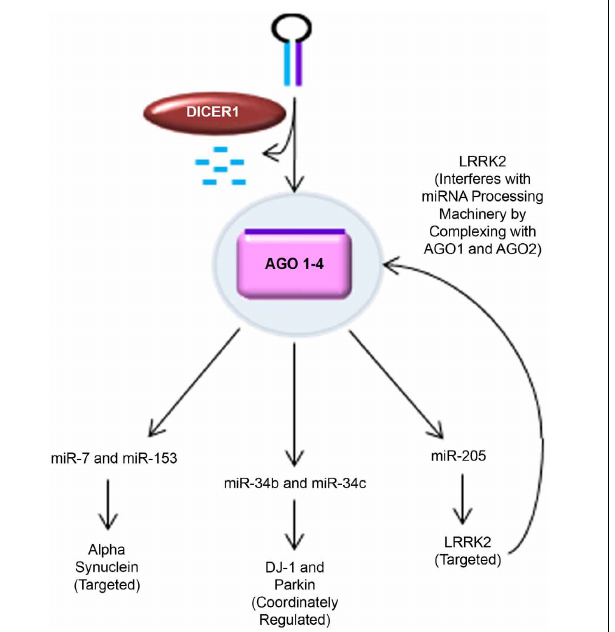
FIGURE 2 | MiRNA regulation of PD-related genes. Novel findings supporting the role of miRNA in regulating key PD-related genes are shown. Alpha synuclein was predicted to have seed sequences in the 3 (cid:3) UTR for miR-7 and miR-153. This was experimentally validated by Junn et al. (miR-7) and Doxakis (miR-7 and miR-153) in several PD-relevant models, including mice challenged with MPTP and MPP + -treated SH-SY5Y cells. DJ-1 and Parkin were found to be coordinately regulated with miR-34b and miR-34c expression in PD patient brains and SH-SY5Y cells (Minones-Moyano et al., 2011). LRRK2 was putatively predicted to be regulated by miR-205 and experimentally confirmed in post-mortem PD patient brain samples, primary cultured mouse cortical neurons, and LRRK2 R1441G BAC transgenic mice (Cho et al., 2013). Interestingly, pathogenic LRRK2 has also been found to interfere with miRNA processing machinery by complexing with drosophila AGO1 and human AGO2 (Gehrke et al.,